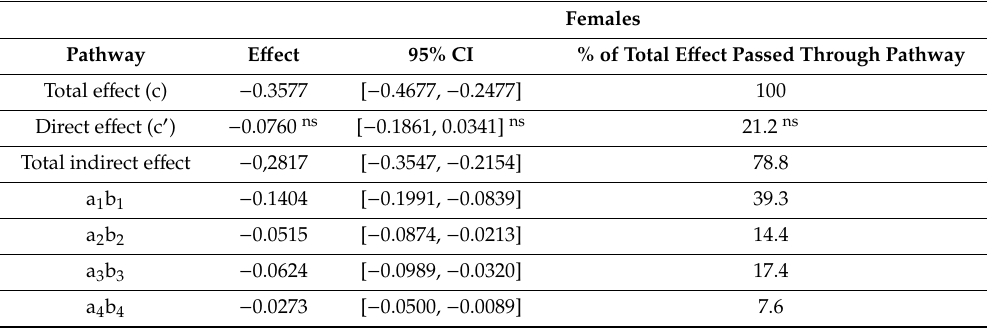
Table 5. Direct and indirect e ff ects for mediating pathways for females of the relationship between stress in 2012 and work ability in 2017 in a parallel design ( n =